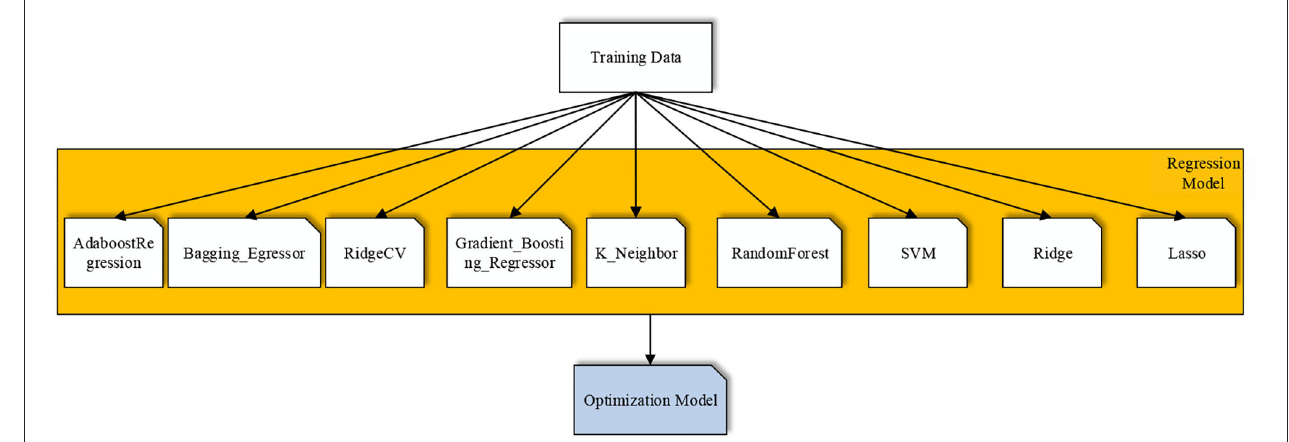
FIGURE 2 | Flow chart of the inverse model of multiple machine learning algorithms.